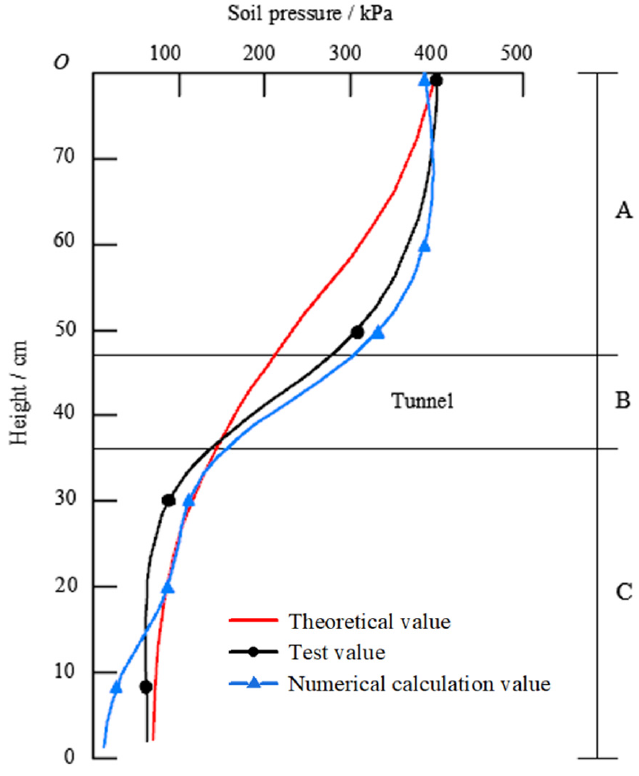
Figure 7. Variation Schematic diagram of the variation of soil pressure with slope height.